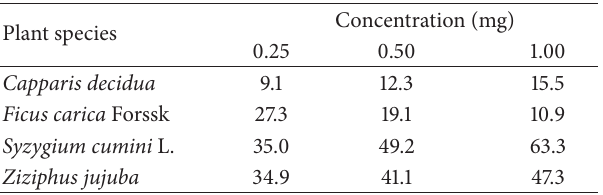
Table 4: Antioxidant activity (%) of the studied plants found from various regions of